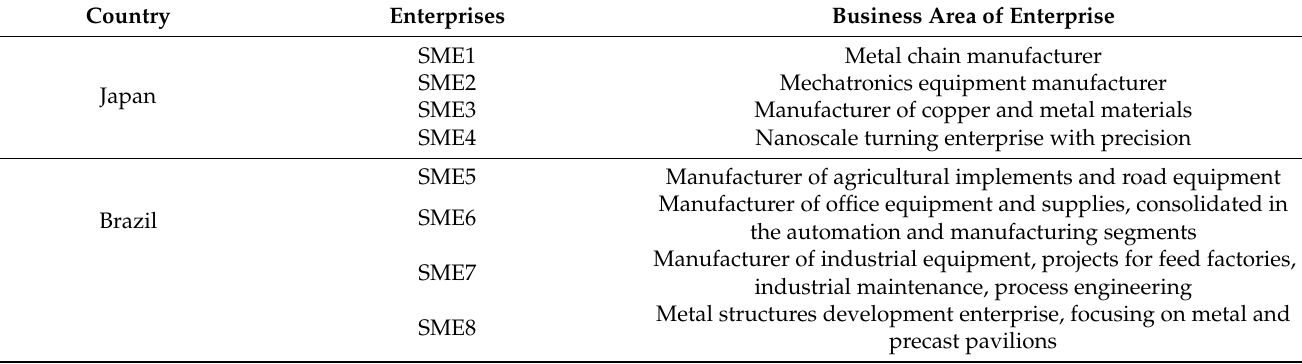
Table 7. Selected Japanese and Brazilian SMEs.